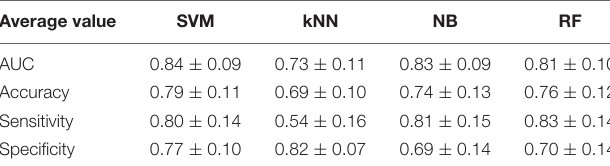
TABLE 3 | Comparison of different models in the validation